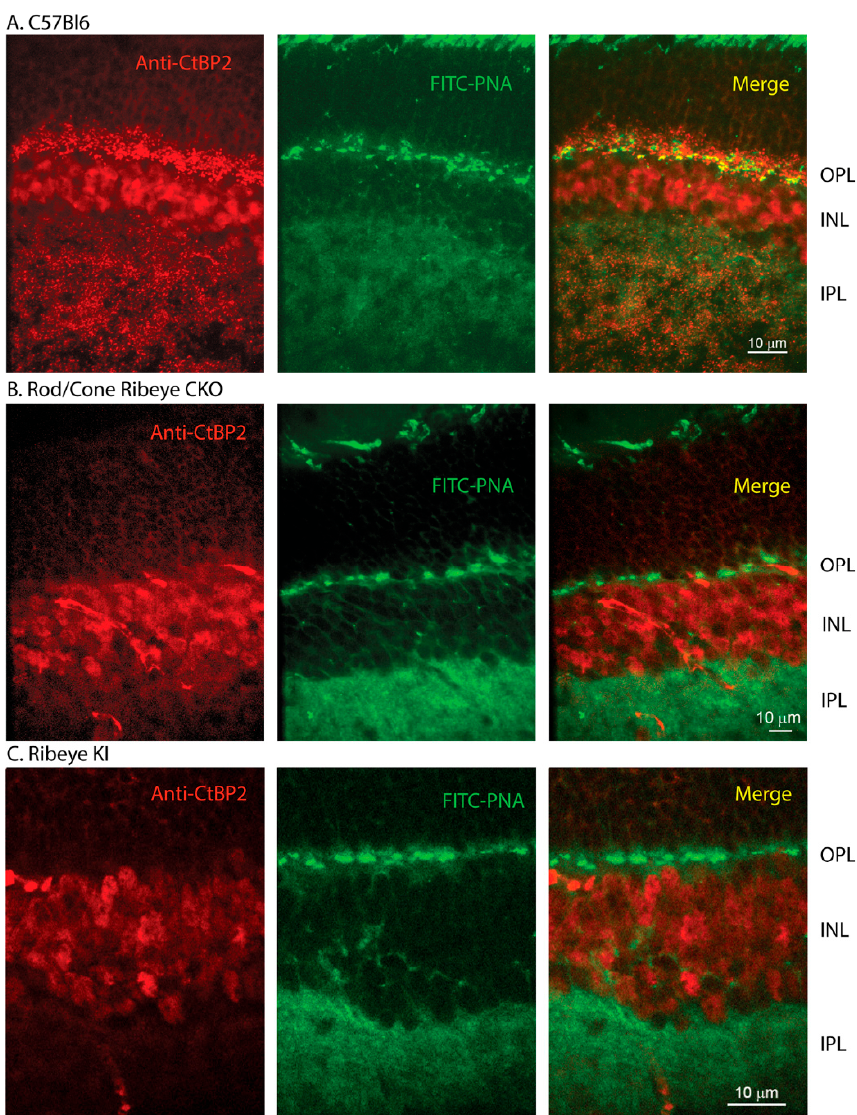
Figure 1. Synaptic ribbons are absent from retinas of both rod/cone Ribeye CKO and Ribeye KI mice. ( A ) Wild-type C57Bl6J retina labeled with a primary antibody to the B-domain of RIBEYE (Synaptic Systems, 192-003) and visualized with rhodamine-conjugated secondary antibody-labeled ribbons in the OPL and IPL along with somas in the INL. The base of cone pedicles was strongly labeled by FITC-conjugated peanut agglutinin (FITC-PNA, green). ( B ) Ribbon labeling with the B-domain antibody was eliminated from the OPL, but also from the IPL in rod/cone Ribeye CKO retina (Rho-iCre × HRGP-Cre × Ribeye fl/fl ). Labeling of the INL remained in place. ( C ) Ribbon labeling was also eliminated from retinas of Ribeye KI mice while labeling of the INL remained.